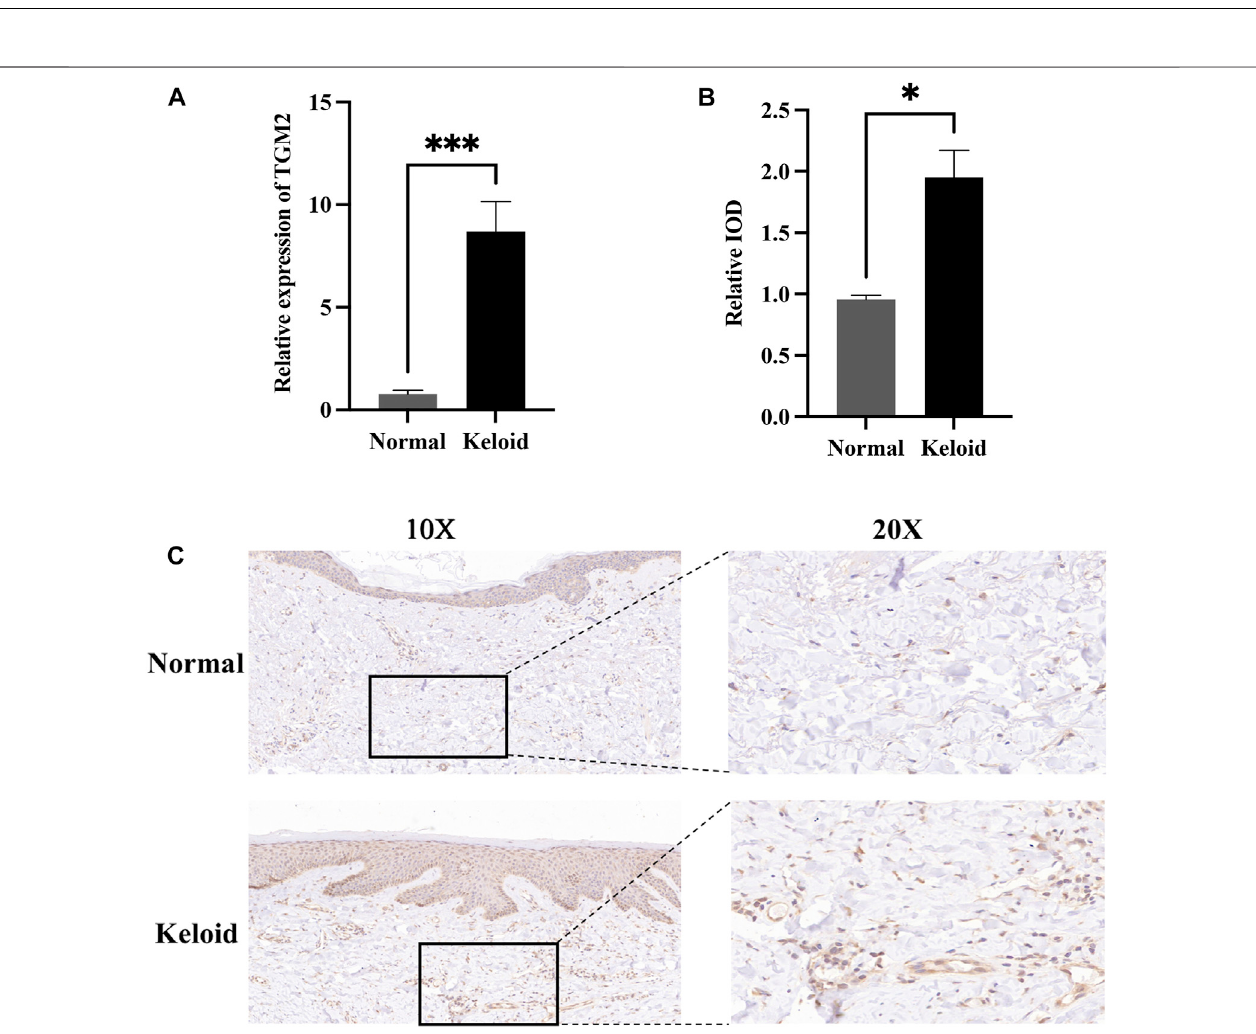
FIGURE8| ExpressionofTGM2inkeloidsandnormalskintissues. (A) TheexpressionofTGM2inkeloidtissuescon fi rmedbyRT-qPCR.TheexpressionofTGM2 mRNA in keloids was signi fi cantly higher than that in normal skin tissues(P.value= 0.0003). (B) The relative IOD (integrated optical density) value of TGM2 in keloids and normal skin tissues. (C) Immunohistochemical staining of TGM2 in keloids and normal skin tissues.